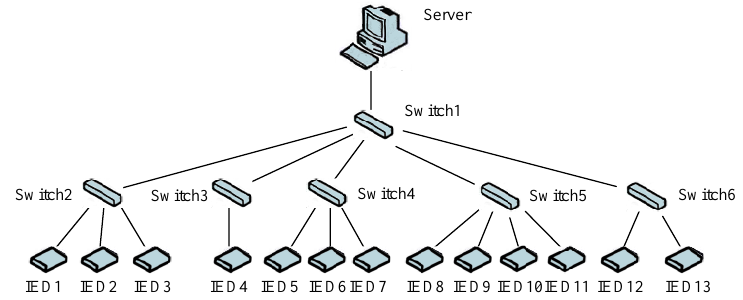
Figure 13. Cyber system structure.